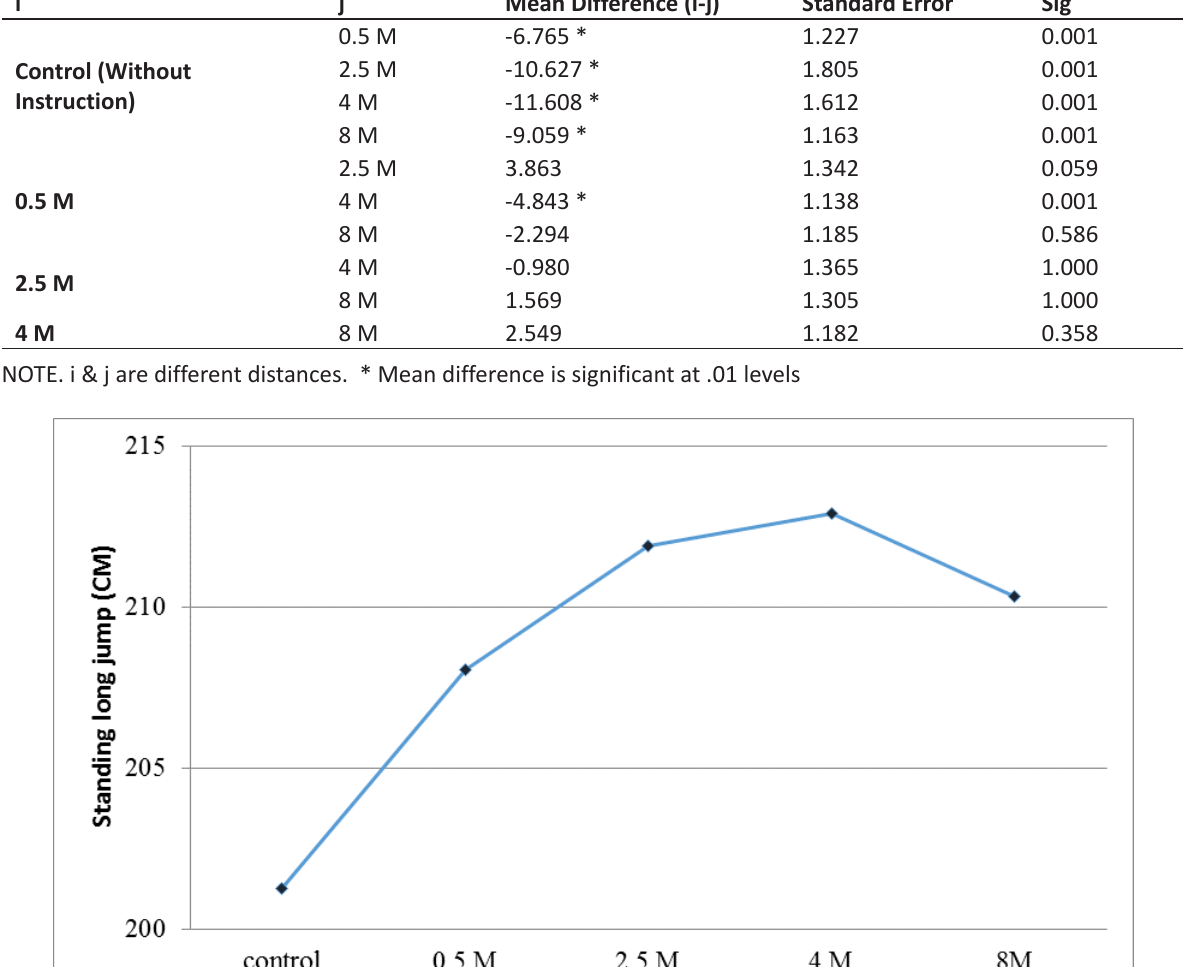
Table 2: Bonferroni test results compared to performance of athletes at different distances of external attention focus i